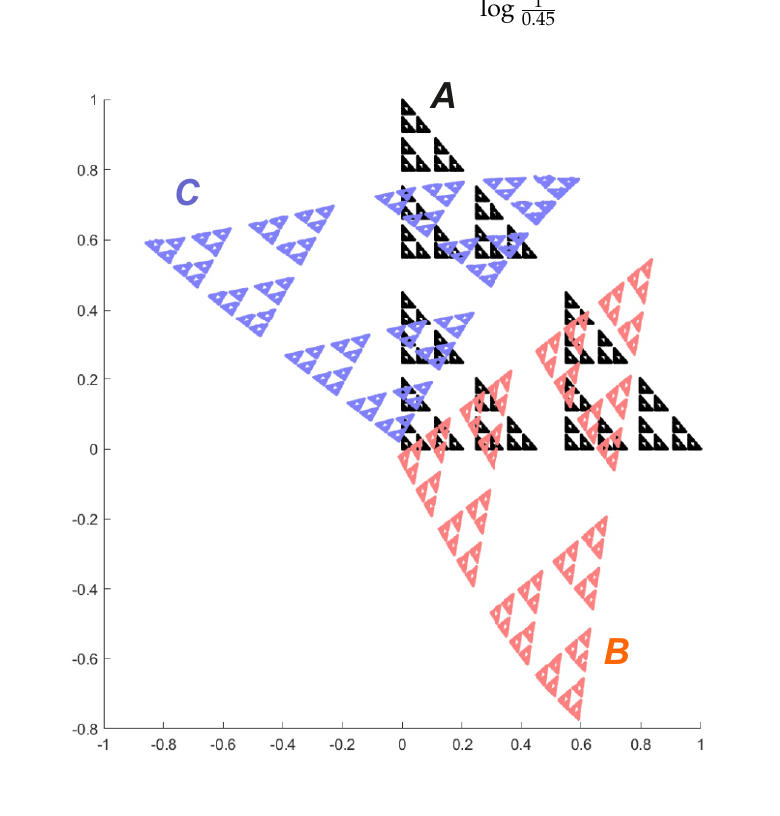
Figure 1. Attractor A = I ( A ) , attractor B = T 1 ( A ) and attractor C = T − 1